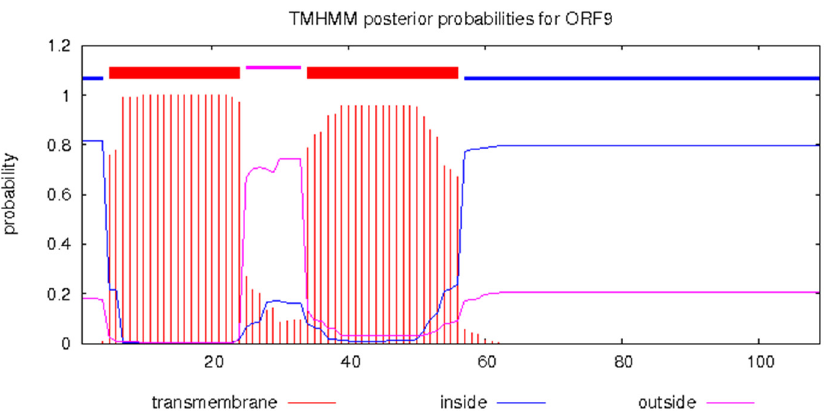
Figure 10. Predicted hypothetical protein ( gp 09, GenBank No. QSJ04729) transmembrane structure using the TMHMM prediction server. Red blocks are predicted transmembrane domains on the top line, while the abscissa represents the sequence position, and the ordinate represents the prediction probability.